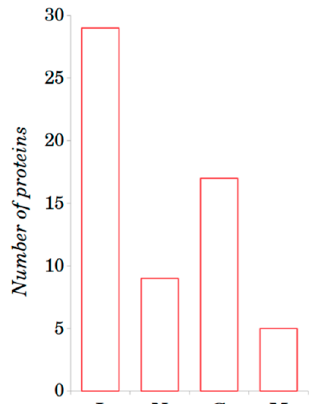
Figure 2. Distribution of MFHD PDB segments in the full UniProt sequences. (I: Amino acid sequence from UniProt is identical with amino acid sequences of MFHD PDB segment amino acid sequences; N: MFHD PDB segment is located in N-terminus of the amino acid sequences from UniProt; C: MFHD PDB segment is located in C-terminus of the amino acid sequences from UniProt; M: MFHD PDB segment is located in middle of the full amino acid sequence from UniProt).